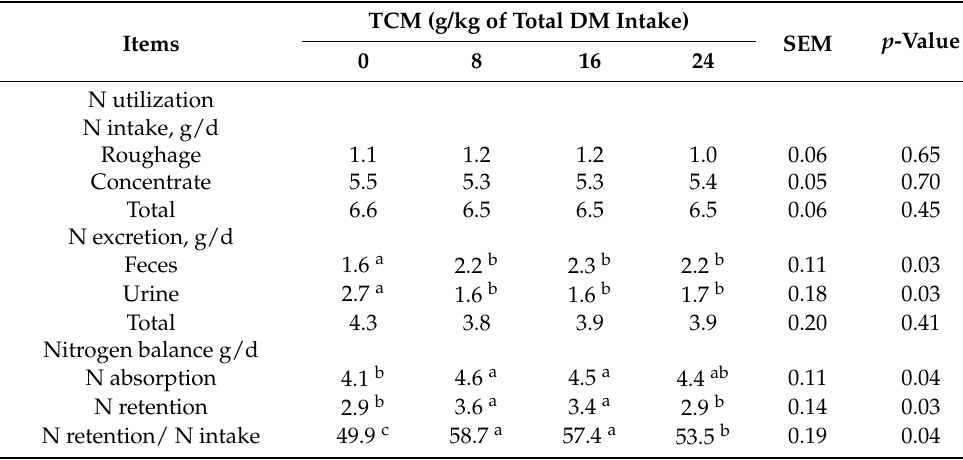
Table 5. Effect of Terminalia chebula meal (TCM) meal supplementation on N